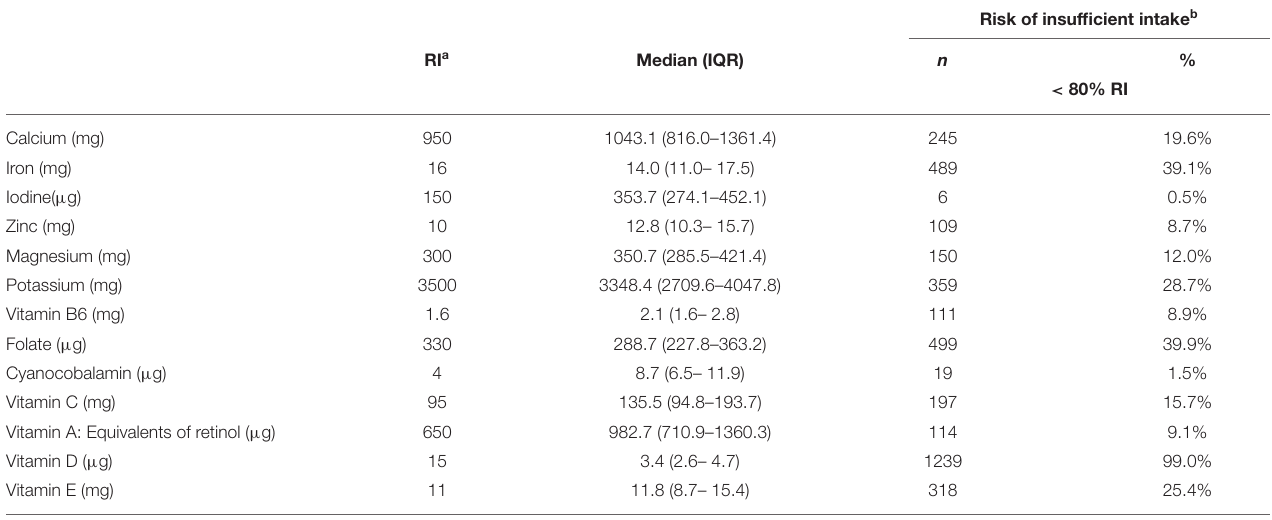
TABLE 2 | Micronutrient daily intake and percentage of women at risk of insufficient